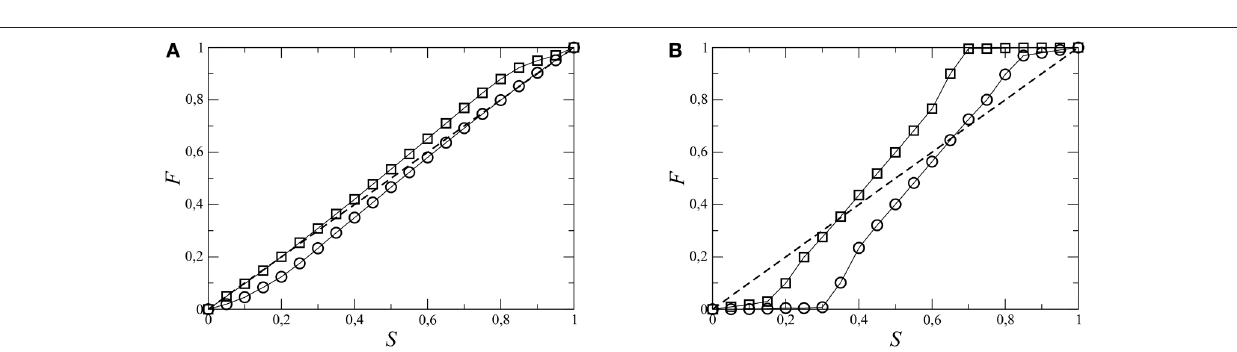
FIGURE 5 | Oil fractional-flow ( F ) in the steady state at different oil saturation ( S ) in the initial oil-wet system ( (cid:13) ) and after the wettability alteration ( 2 ). There is no cut-off in the wetting angle change in these simulations and therefore θ = 0 ◦ here. Individual simulations are performed for all S values at two different capillary numbers (A) Ca = 10 − 1 and (B) Ca = 10 − 2 . F is higher after wettability alteration for the whole range of S . The diagonal dashed line represents F = S curve, miscible fluids without any capillary pressures at the menisci would follow that